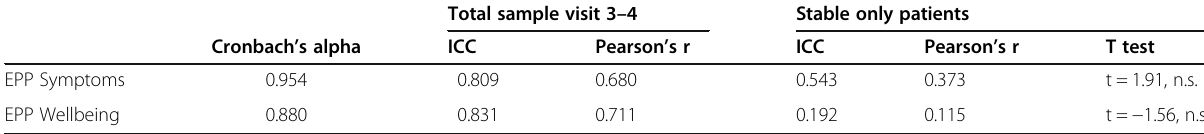
Table 3 Internal consistency and test-retest reliability for the EPP-Qol subscales